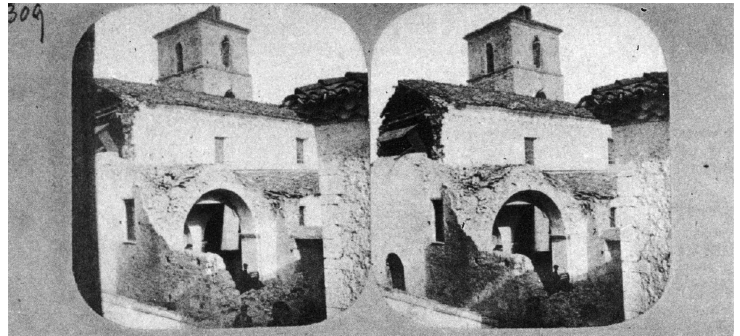
Fig. 6. Damage to the Church of St. Angelo della Trinità according to the Mallet’s report (Mallet, 1862, stereo- scopic photo no.